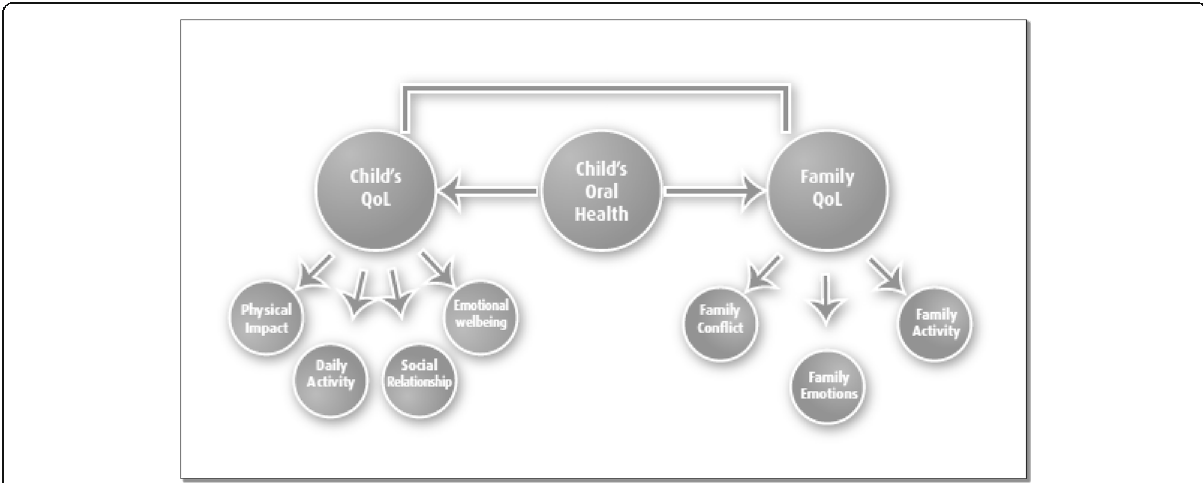
Fig. 3 Impacts of Child ’ s oral health on his/her QoL and that of the family as